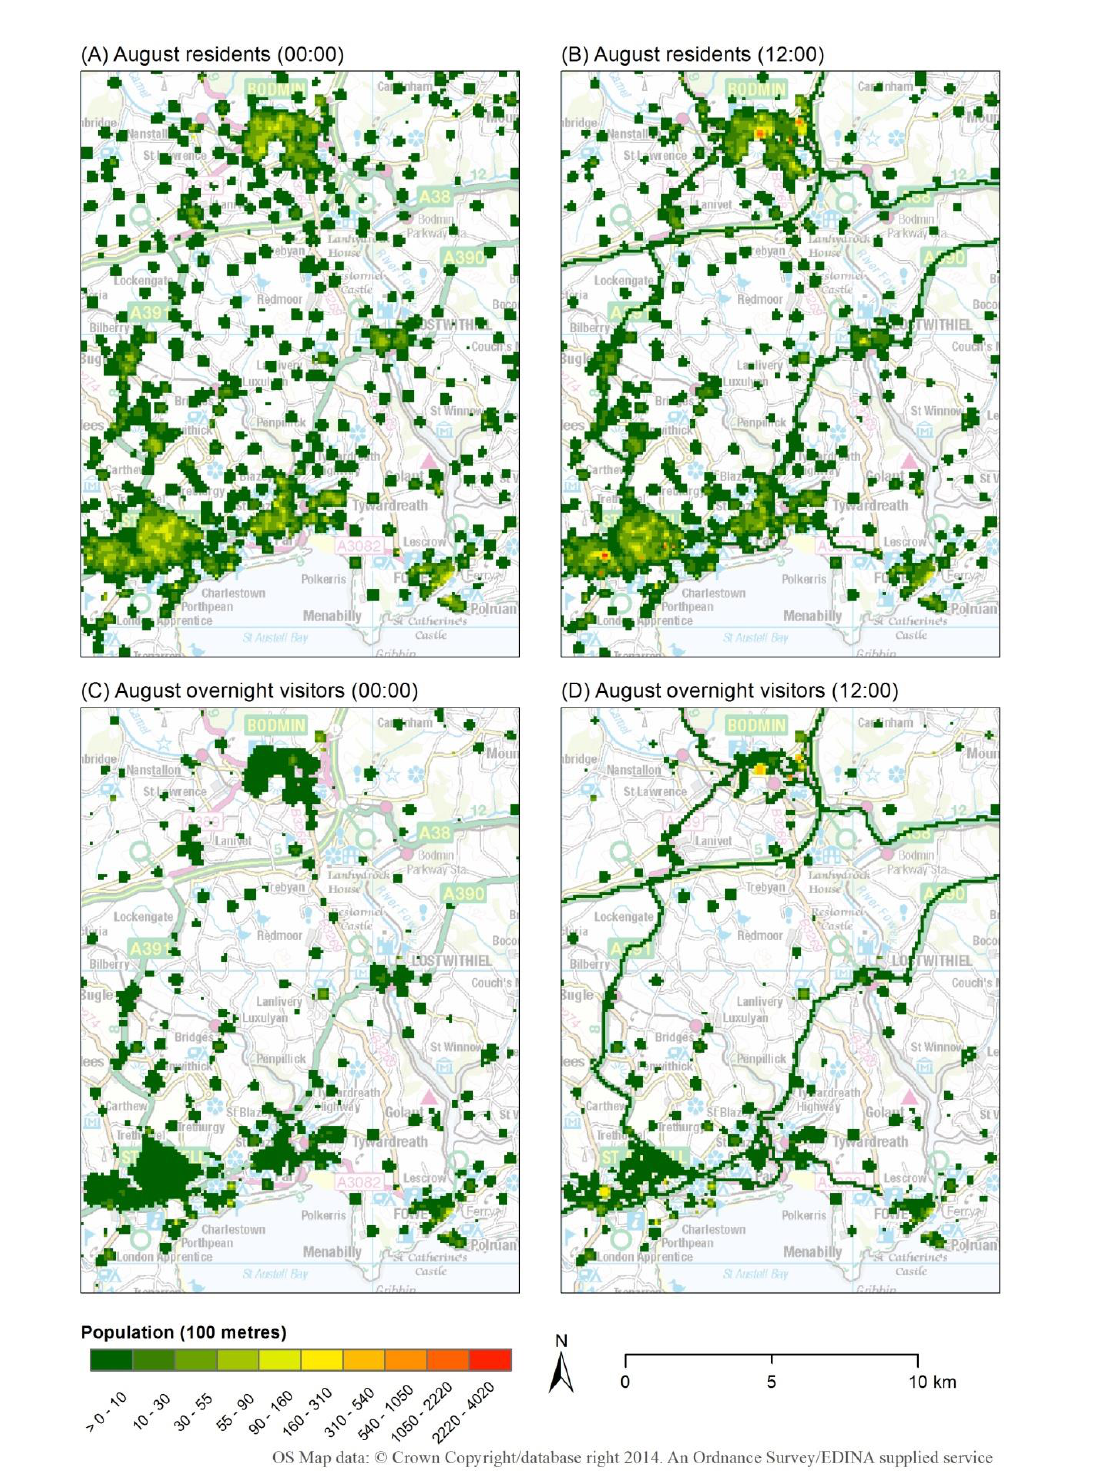
Figure 8. Modelled seasonal population distribution (100 m) for the St Austell study area for a August weekday. ( A ) usually resident night-time (00:00) population, ( B ) usually resident daytime (12:00) population, ( C ) overnight visitor night-time (00:00) population and ( D ) overnight visitor daytime (12:00)